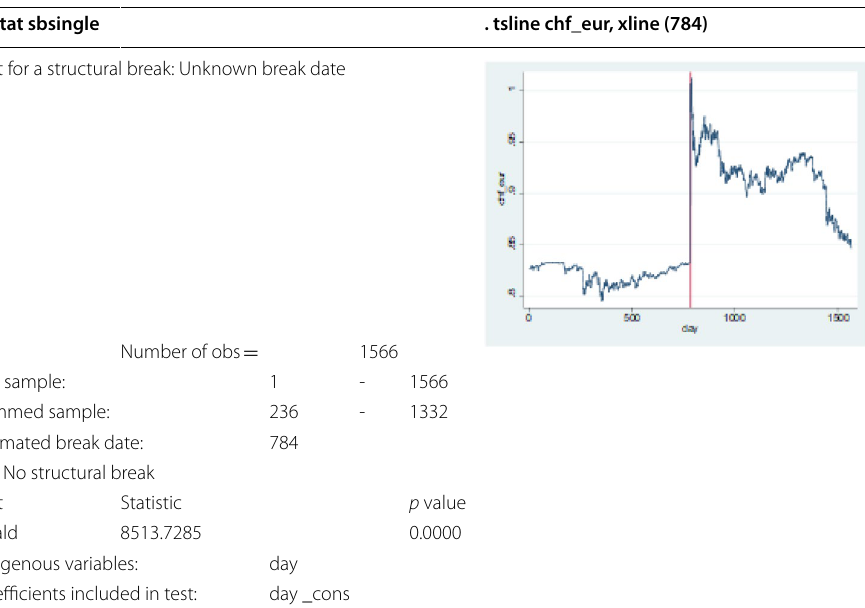
Table 8 Test for structural breaks in instrumental variable (chf_eur) . estat